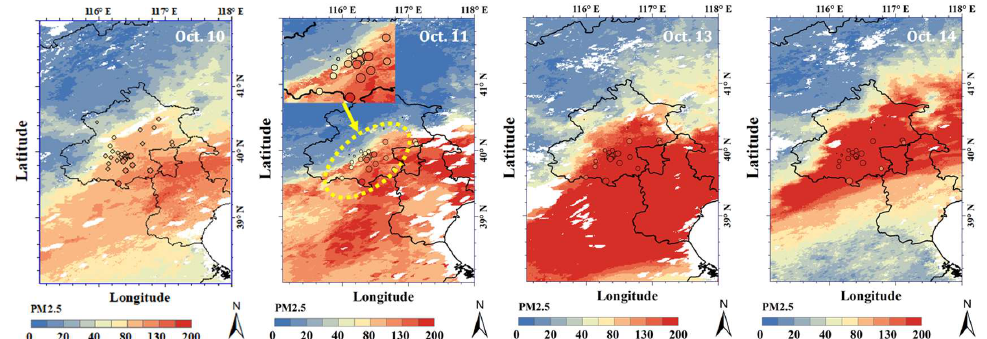
Figure 17. Performance of SPSEMCA during a heavily polluted period in the Beijing area, 2016. Points refer to the ground-based PM 2.5 measurement stations from BAQMN; the color and size of the points refer to the concentration of PM 2.5 .